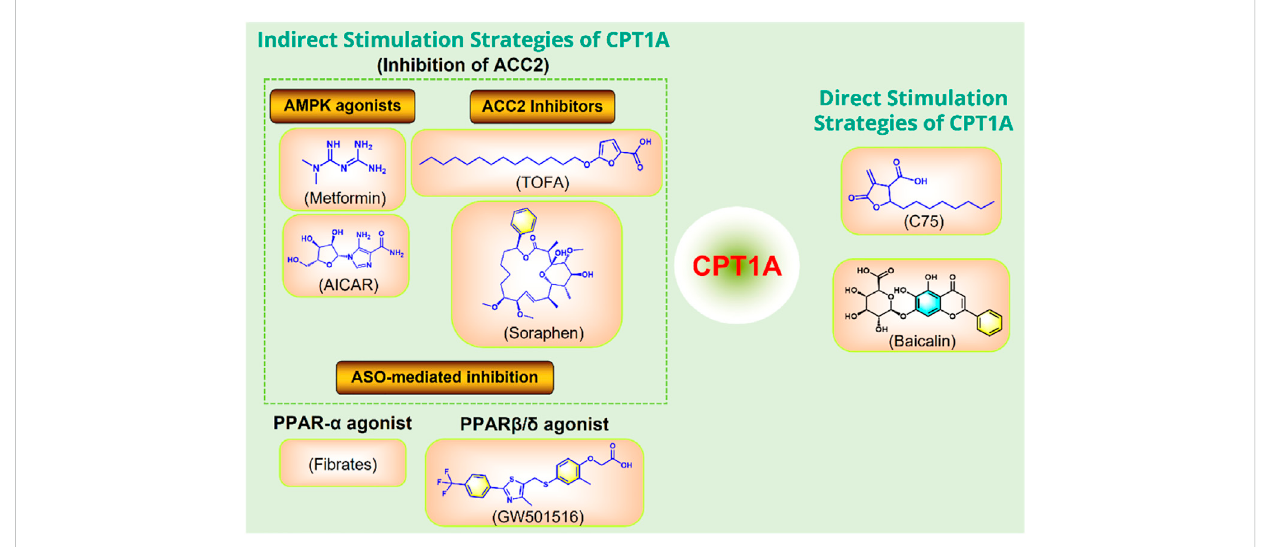
FIGURE 10 Strategies to directly or indirectly stimulate CPT1A. ASO, antisense oligonucleotide; PPAR, peroxisome proliferator activated receptor; ACC, acetyl- CoA carboxylase; AMPK, adenosine monophosphate-activated protein